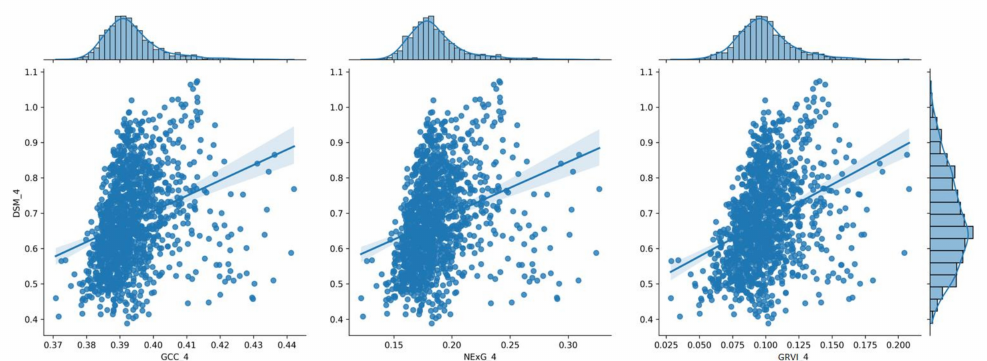
Figure 9. The distribution of the three (3) vegetation index values for the 3rd measurement (55 DAS), shown in a histogram in relation to the corresponding DSM values.